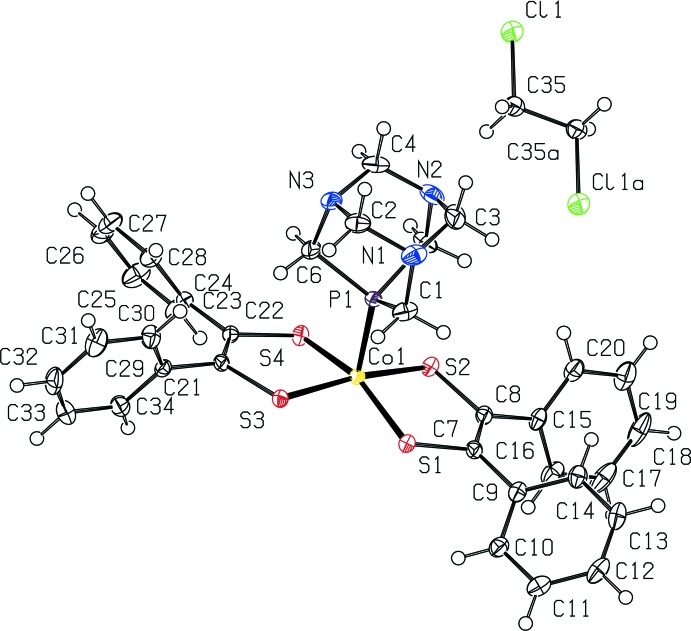
View of [Co(C14H10S2)2(C6H12N3P)]·0.5C2H4Cl2 with 50% probability ellipsoids.